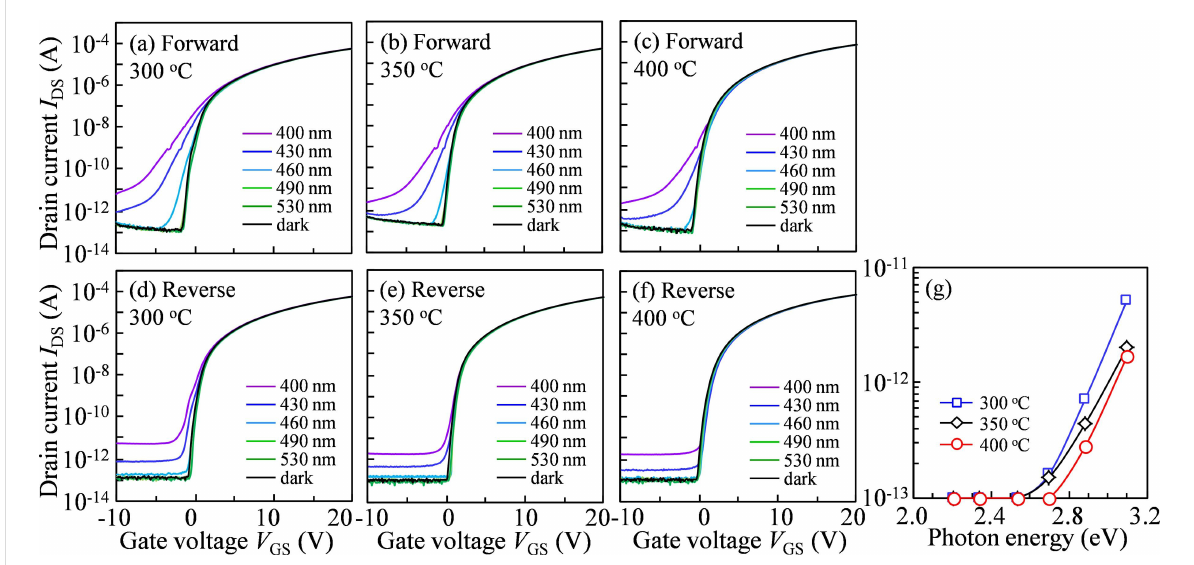
Figure 2: Transfer curves scanned in the forward direction for a-IGZO TFTs annealed at (a) 300 °C, (b) 350 °C, and (c) 400 °C and scanned in the reverse direction for the devices treated at (d) 300 °C, (e) 350 °C, and (f) 400 °C under monochromatic light irradiation; (g) photo-leakage current ( V GS = − 10V and V DS = 10 V) of a-IGZO TFTs in the reverse measurement as a function of photon energy of the incident